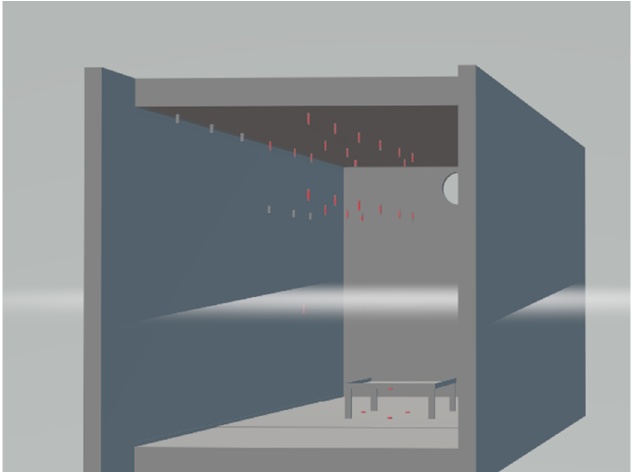
Figure 4. Hydrogen sensors’ placement in the container. Red—CANbus sensors, grey—WIFI sensors.